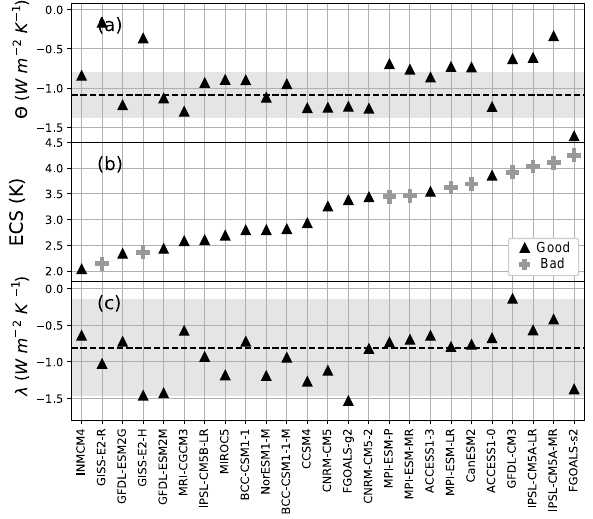
Figure 9. (a) (cid:50) from individual CMIP5 control runs. The dotted line is the estimate from CERES observations; the gray region is the 5–95% confidence band. (b) ECS from each CMIP5 model, estimated from the first 150 years of abrupt 4 × CO 2 runs using the Gregory method (Gregory et al., 2004). “Good” models are those whose (cid:50) agrees with observations in (a) ; “bad” models are those whose (cid:50) does not. (c) Same as (a) but for λ